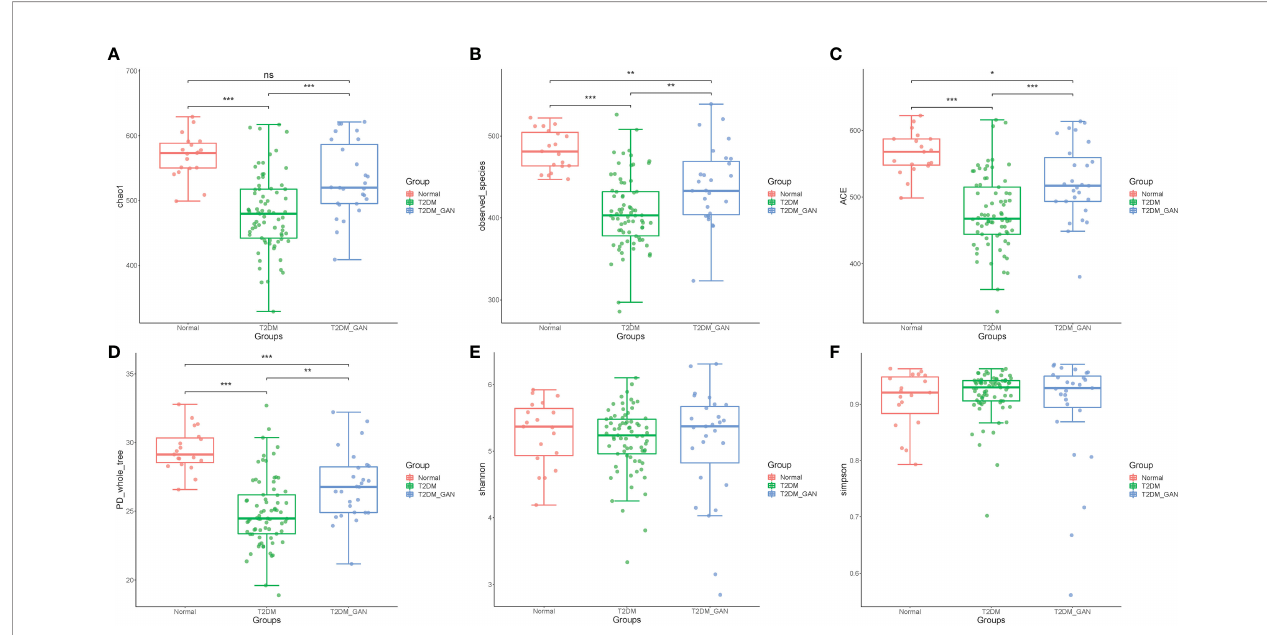
FIGURE 1 | The alpha diversity of the gut microbiota among the subjects. (A) Chao1 index, (B) observed_species, (C) ACE index, (D) PD_whole_tree, (E) Shannon, and (F) Simpson. One-way ANOVA (normal vs . T2DM vs . T2DM_GAN group), multiple comparisons are performed using FDR correction: * p < 0.05, ** p < 0.01, *** p <